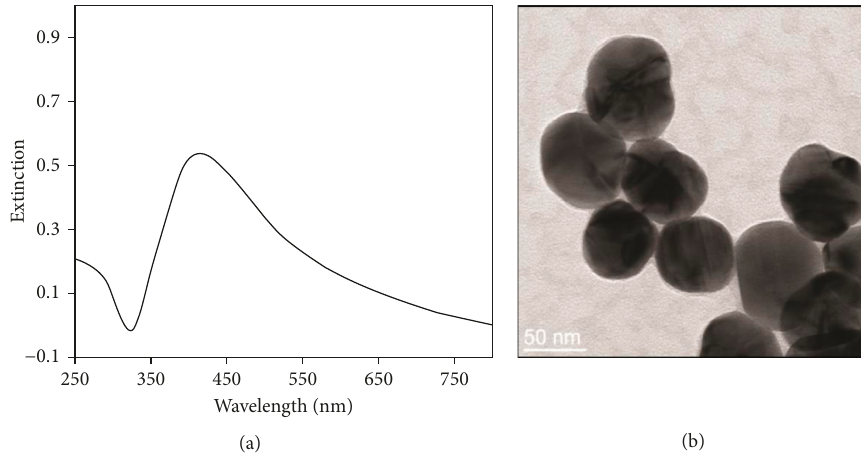
Figure 1: (a) Extinction spectrum of SH NPs. (b) TEM image of the prepared SH NPs.